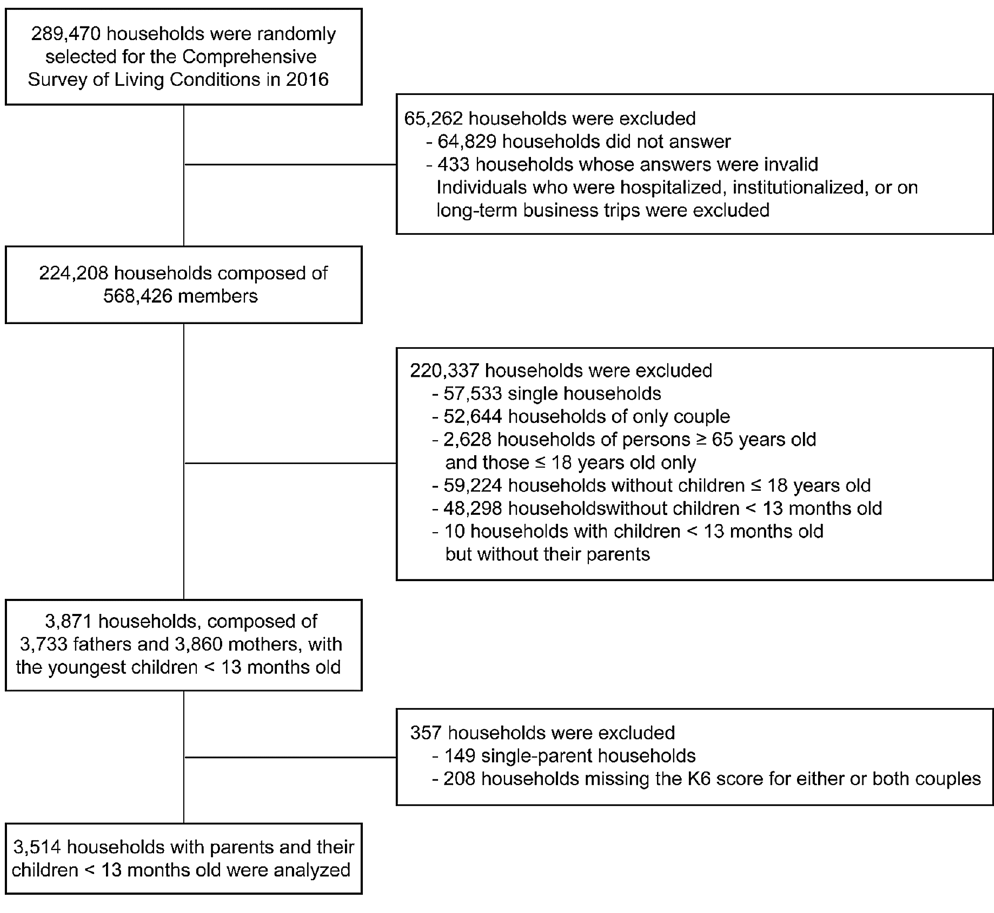
Figure 1. Flow chart of data